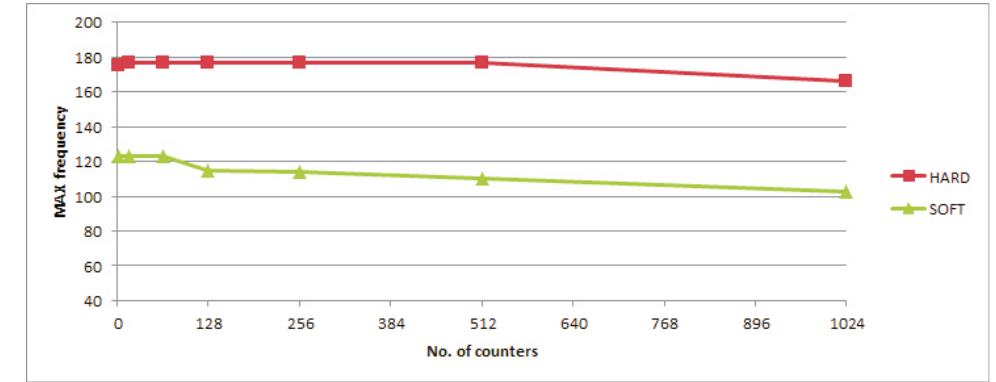
Figure 15. The time analysis for hardware and software-like counters ([MHz]).